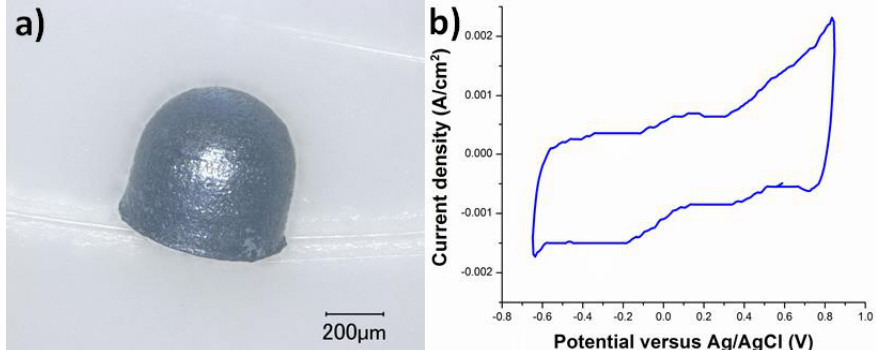
Figure 5. ( a ) Optical microscope image of IrO x -coated bullet-shaped titanium microelectrode; ( b ) cyclic voltammogram of IrO x -coated bullet-shaped titanium microelectrode.